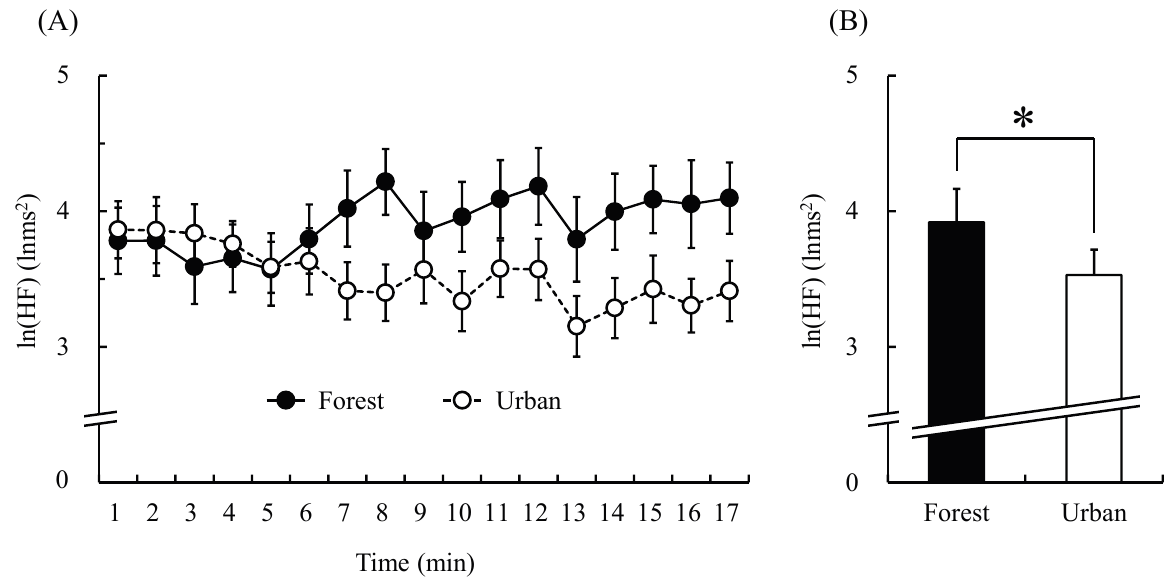
Figure 2. ln(HF) value of heart rate variability during the forest and urban walk. ( A ) Changes in each 1-min average ln(HF) value over the 17-min walk. ( B ) Overall mean ln(HF) values. N = 19, mean ± standard error. * p < 0.05, paired t